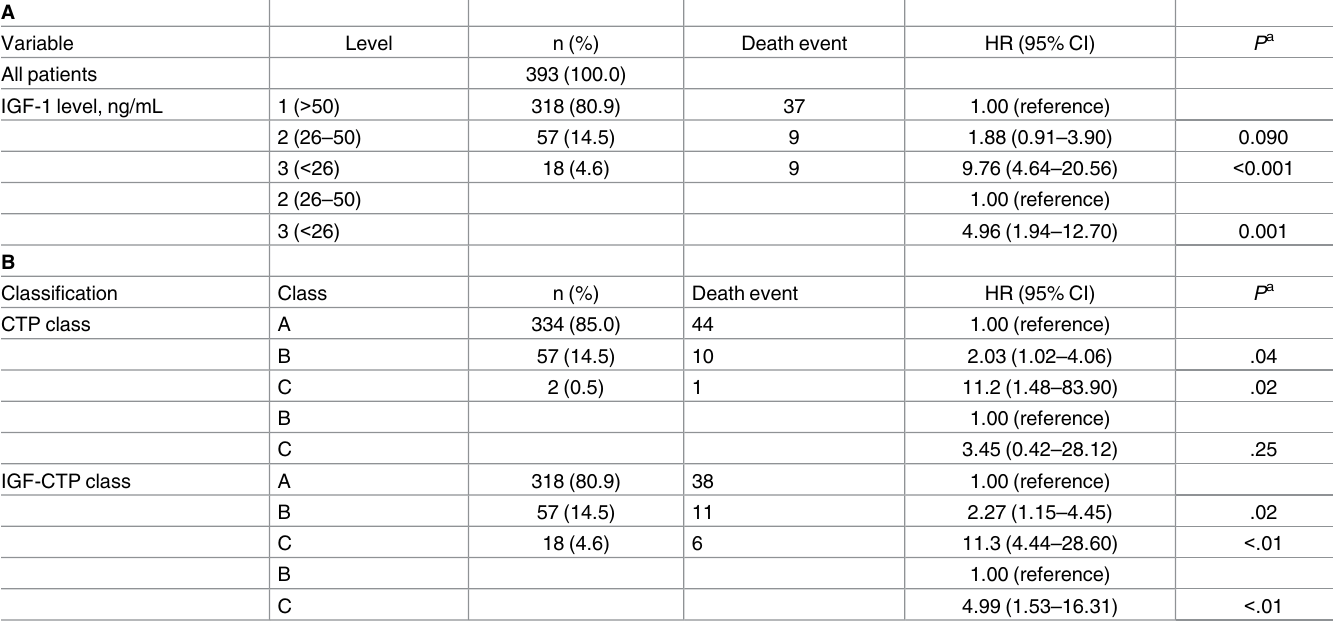
Table 2. Cox model results for overall survival of the cohort based on insulin-like growth factor 1 (A), and both classifications